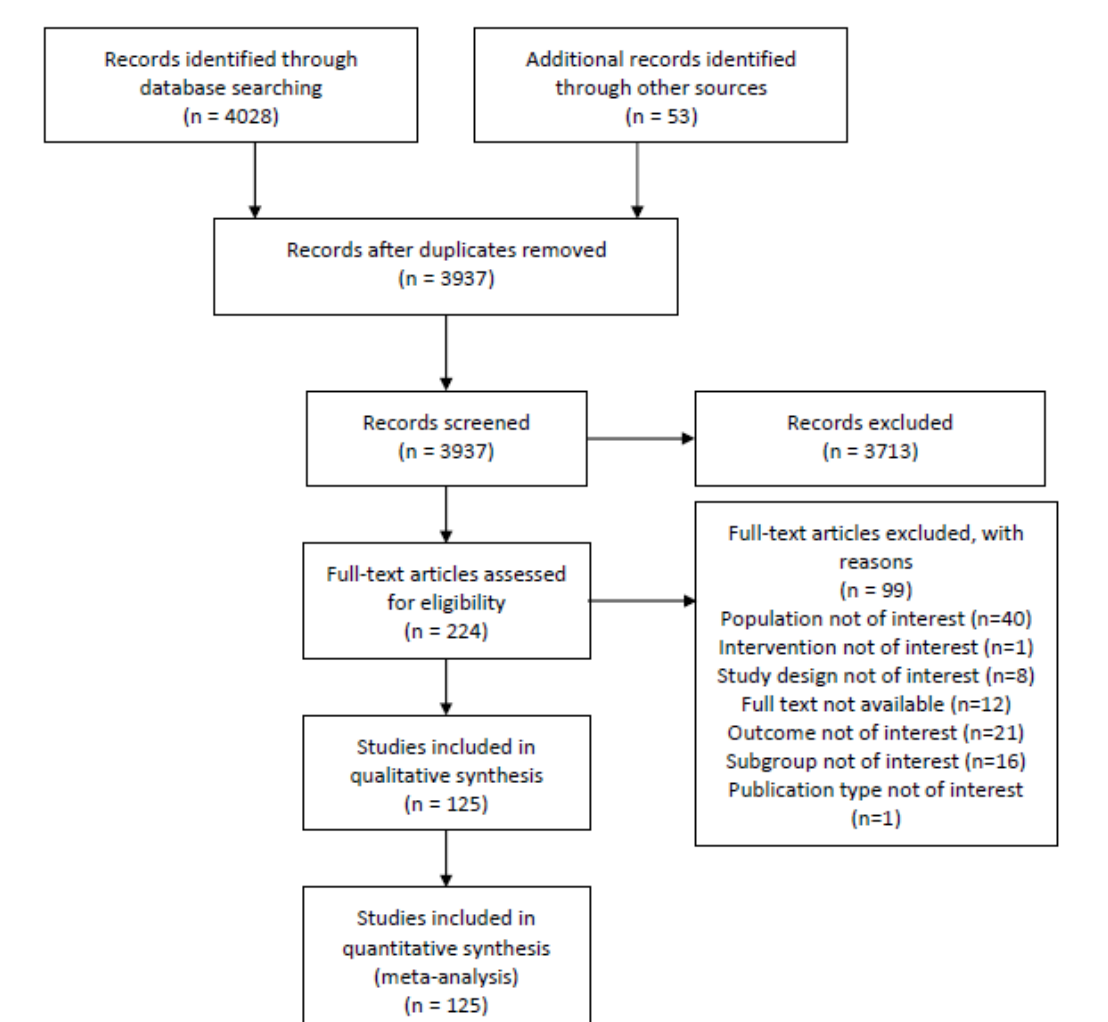
Figure 1. PRISMA diagram of the literature selection in this systematic literature review and meta-analysis.